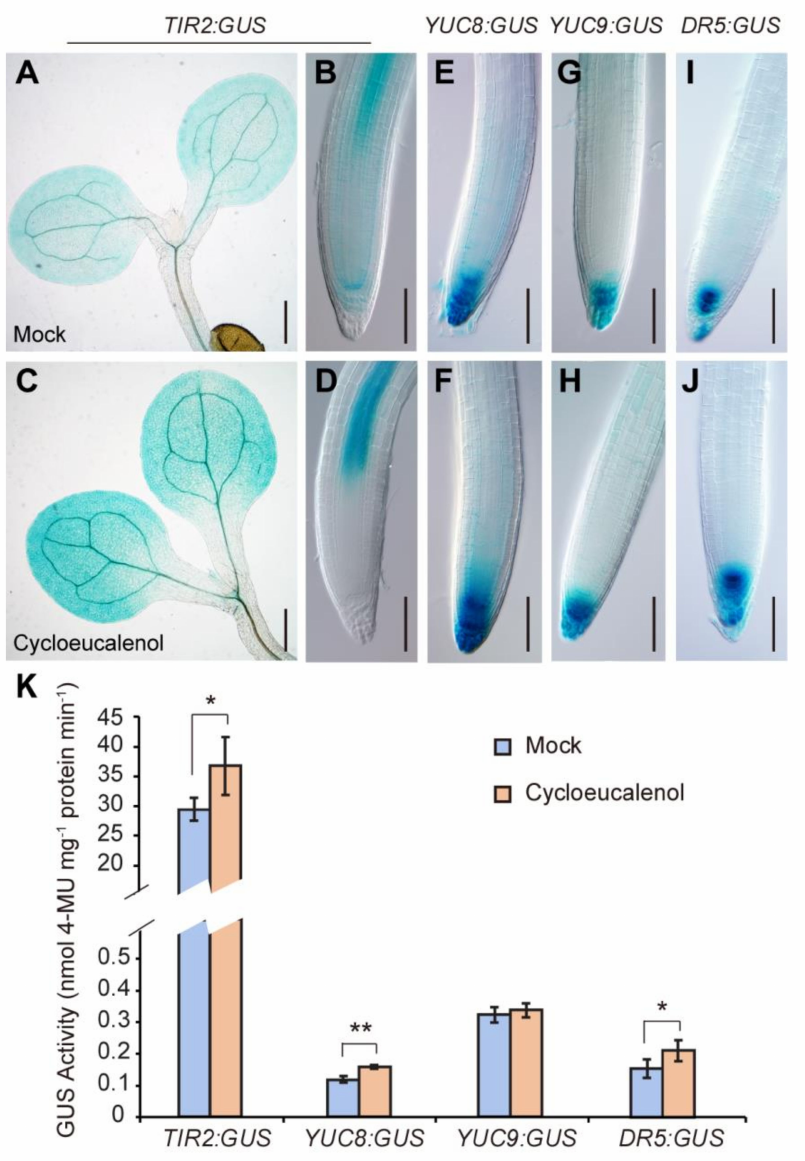
Figure 5. Cycloeucalenol enhances auxin biosynthesis genes and DR5:GUS auxin response reporter expression. ( A – D ) Expression patterns of ProTIR2:GUS in shoots ( A , C ) and root tips ( B , D ) of 5- day-old WT seedlings grown on MS medium containing 0.1% acetone solvent (mock) or 1 µ M cycloeucalenol. Shown are representative images of three independent experiments (employing 11 to 26 seedlings per experiment); ( E – J ) Expression patterns of ProYUC8:GUS ( E , F ), ProYUC9:GUS ( G , H ), and DR5:GUS ( I , J ) in root tips of 5-day-old WT seedlings grown on MS medium containing 0.1% ( v / v ) acetone solvent (mock) or 1 µ M cycloeucalenol. Shown are representative images of three independent experiments (employing 10 to 26 seedlings per experiment); ( K ) GUS activity of ProTIR2:GUS , ProYUC8:GUS , ProYUC9:GUS , and DR5:GUS 5-day-old seedlings. The presented data are means ± SD of n = 3 independent experiments. * p < 0.05, ** p < 0.01 (Student’s t -test, one-tailed, two-sample equal variance). Bars = 400 µ m in ( A , C ) and 100 µ m in ( B , D – J